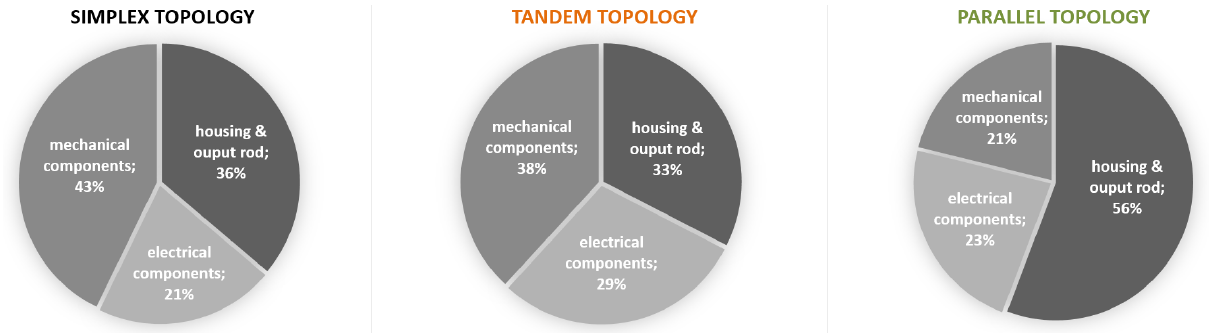
Figure 23. Component mass distribution for one actuator.